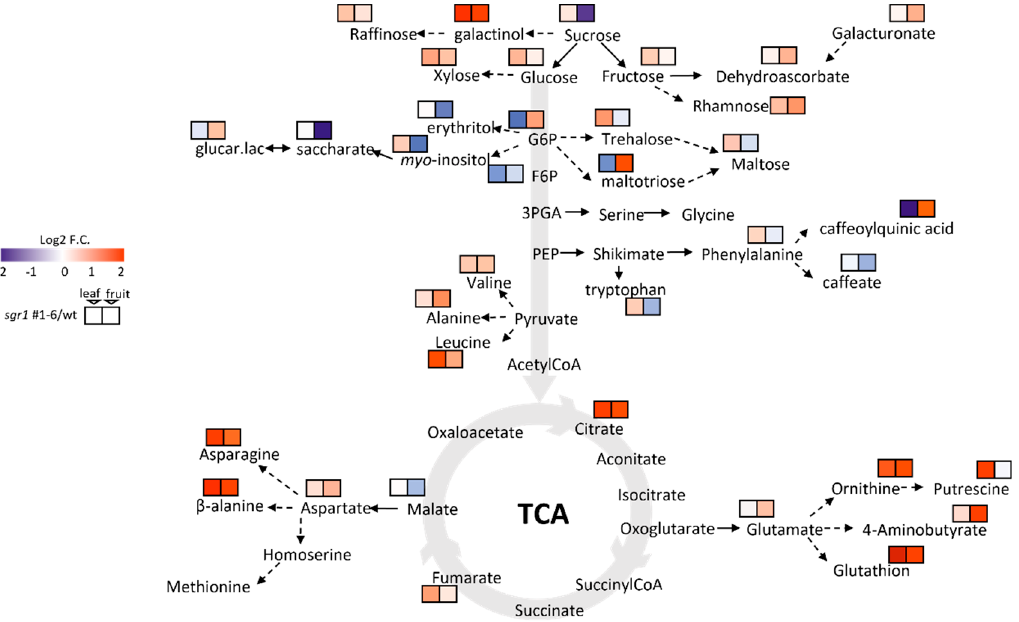
Figure 6. Metabolite profiling of sucrose and its derivatives, glycolytic intermediates, and TCA cycle intermediates in the leaves and fruits as a result of sgr1 knockout in tomato. Primary metabolite profiling of Br+7 stage fruits and leaves in sgr1 #1 − 6 and WT plants. Ratios between sgr1 #1 − 6 and WT plants are shown. A non-paired two-tailed Student’s t − test was used to compare each sgr1 #1 − 6 line with its WT plant ( p < 0.05; n = 5).